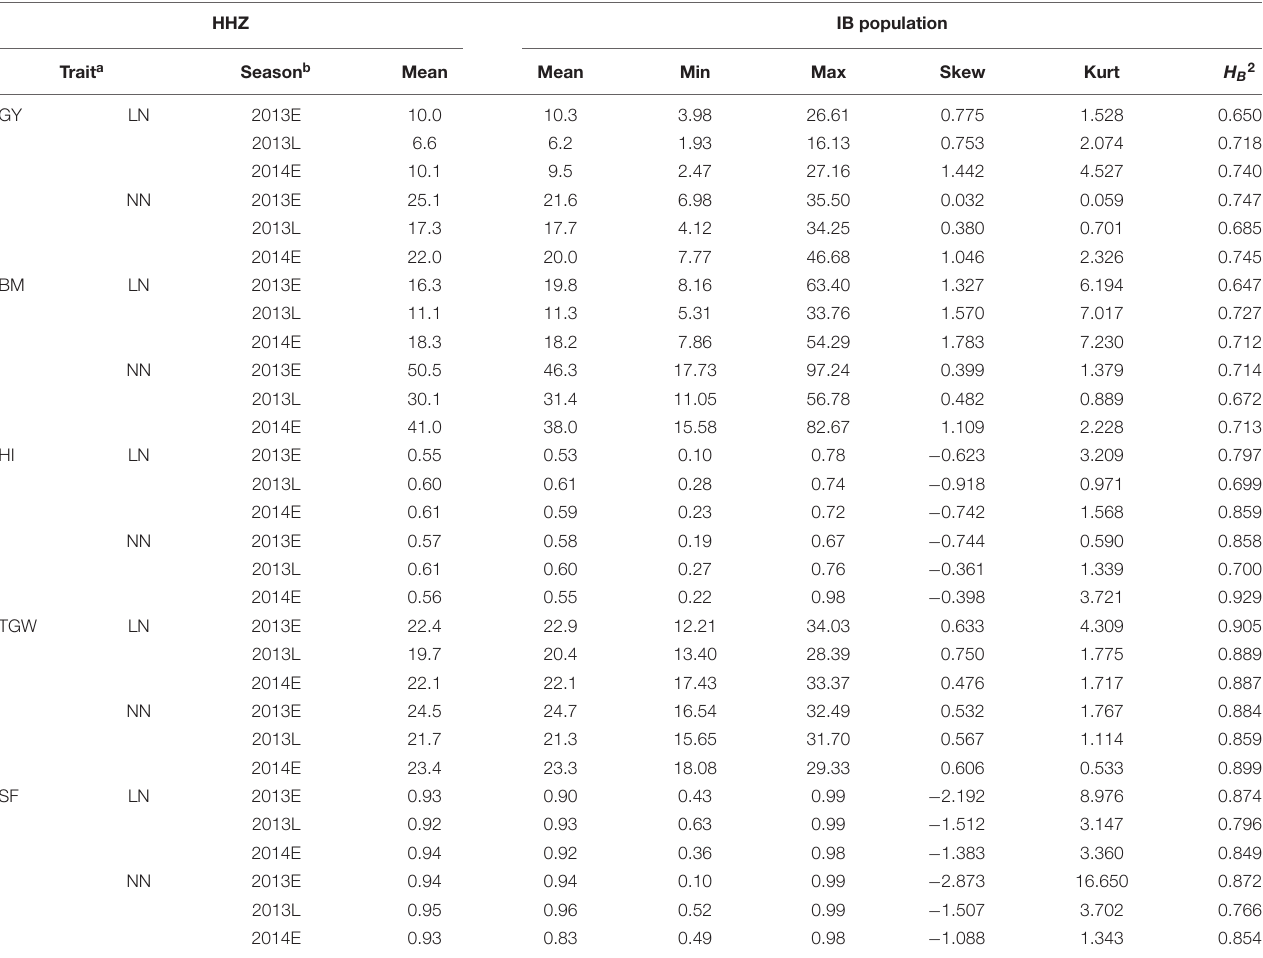
TABLE 1 | Performances of HHZ and IB population under LN and NN conditions in three seasons. HHZ IB population Trait